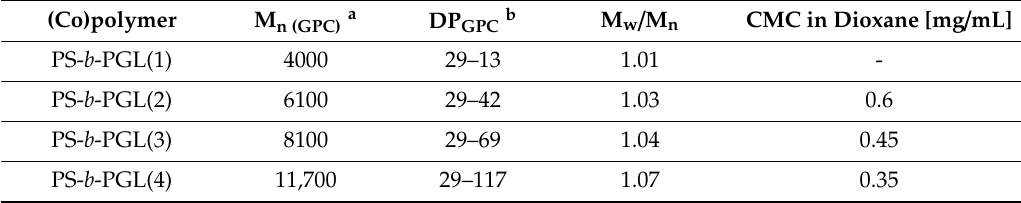
Table 1. Molar masses and dispersities of PS- b -PGL copolymers and their critical micelle concentration in